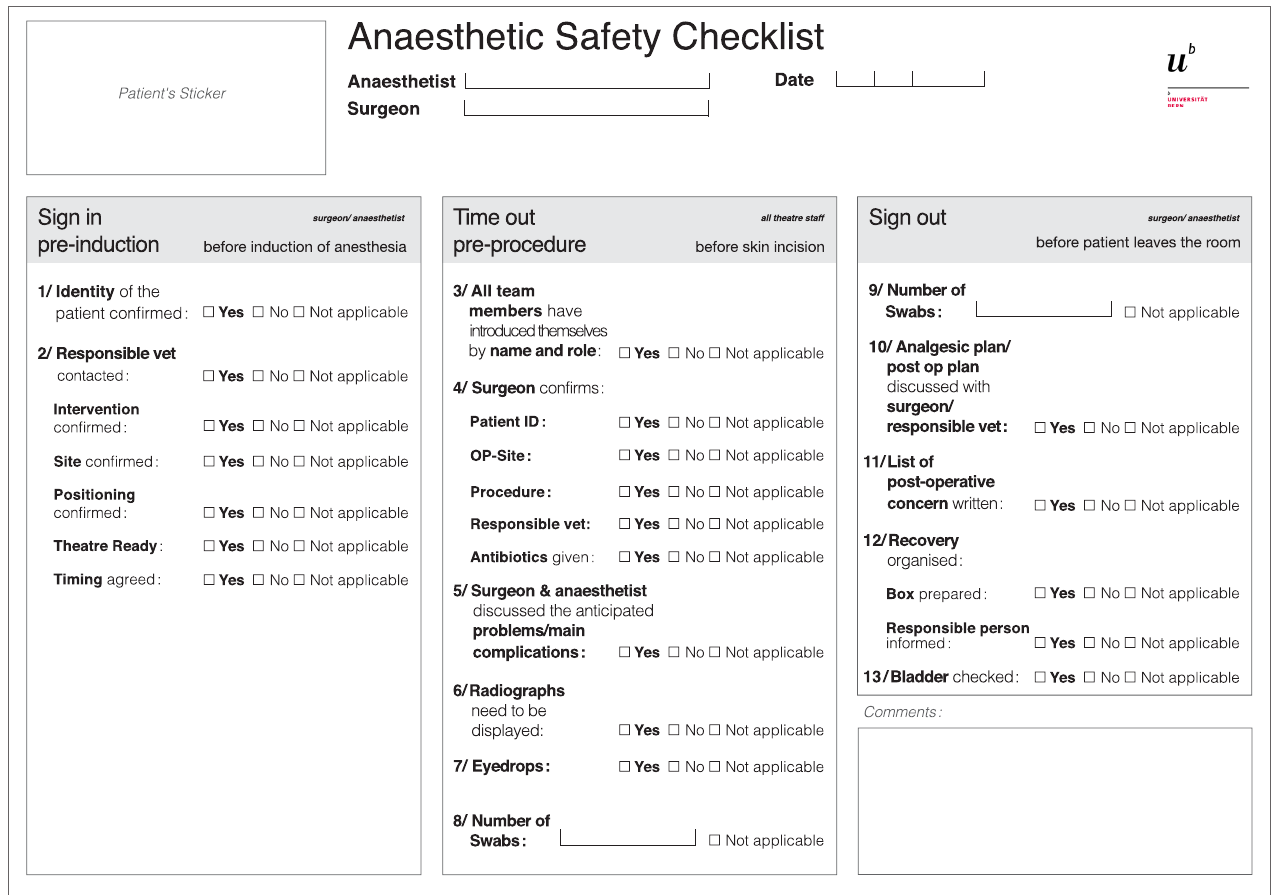
FigUre 2 | Perianesthetic safety checklist from the small animal teaching hospital of the University of Bern, created in expert meetings using the Delphi method and adapted after a 5-week introduction period and a multidisciplinary